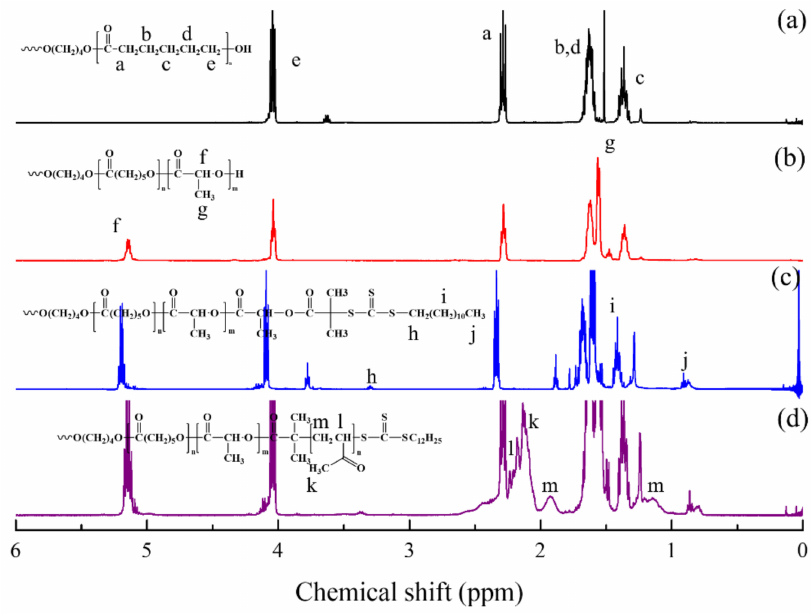
Figure 2. 1 H NMR spectra of ( a ) PCL, ( b ) PCL-b-PLA, ( c ) PCL-b-PLA-TTC, and ( d ) PCL-b-PLA-b-